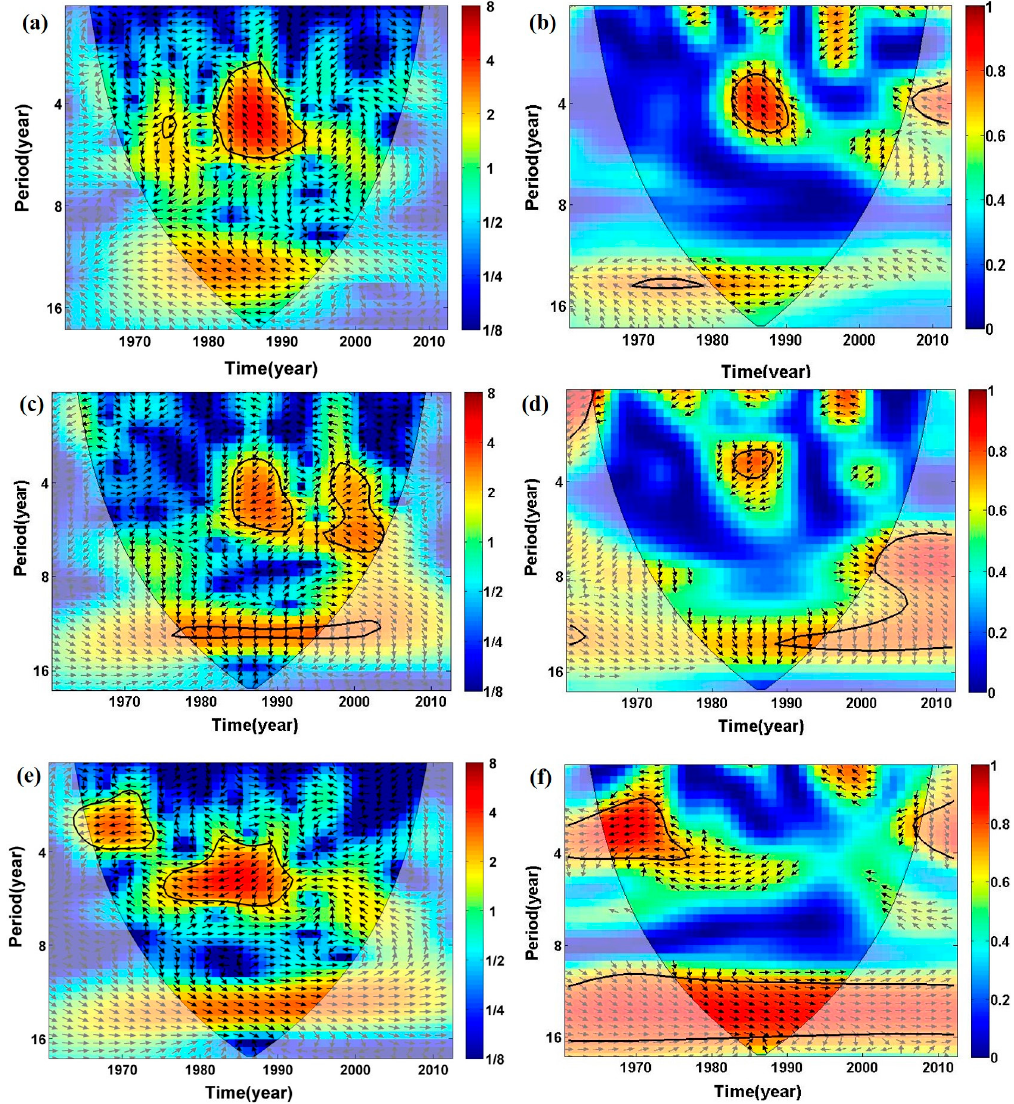
Figure 12. Cross wavelet method (XWT) and wavelet coherence (WTC) for the three principal components ( a ) rotated principal component (RPC)1-XWT; ( b ) RPC1-WTC; ( c ) RPC2-XWT; ( d ) RPC2-WTC; ( e ) RPC3-XWT; ( f )